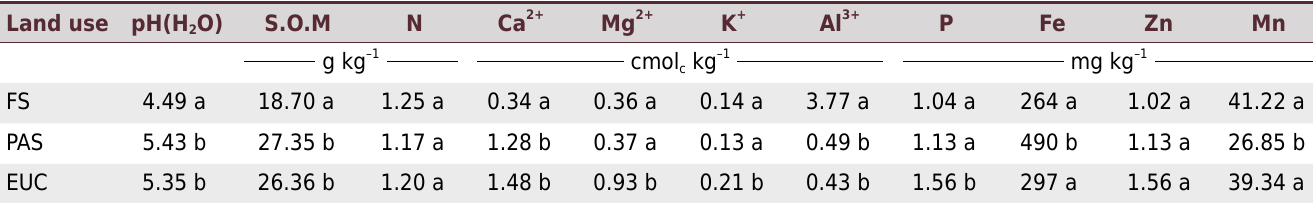
Table 2. Chemical properties in the soil layer of 0.00-0.20 m collected in the Secondary Forest (SF), Pasture (PAS), and Eucalyptus (EUC) in Marabá-PA, Brazil Land use pH(H 2 O)